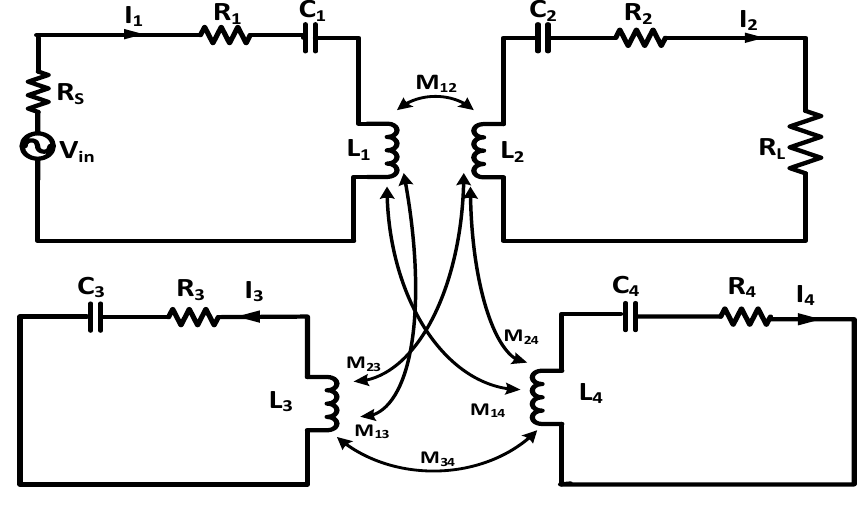
Figure 14. WPT system with the resonant reactive current shielding equivalent circuit